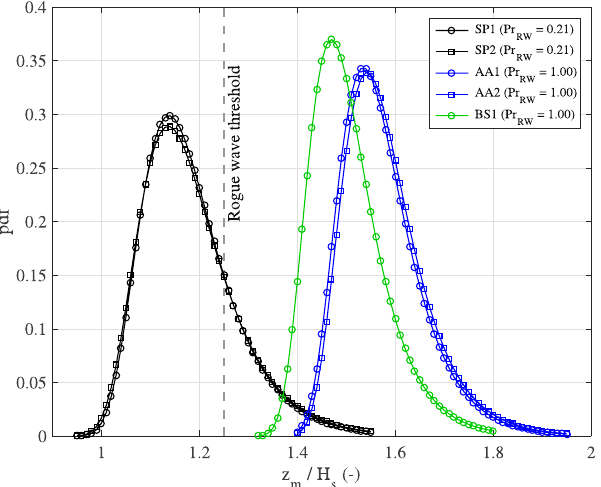
Figure 7. Theoretical probability density function (pdf) of ST extreme second-order nonlinear crest heights. In the legend, Pr RW = Pr{max{ z ( x , y , t )} > 1.25 H s | ( x , y ) ∈ Ω , t ∈ D } is the probability that the maximum crest height over the ST region AD exceeds the rogue threshold z m = 1.25 H s (shown by the dashed gray line).